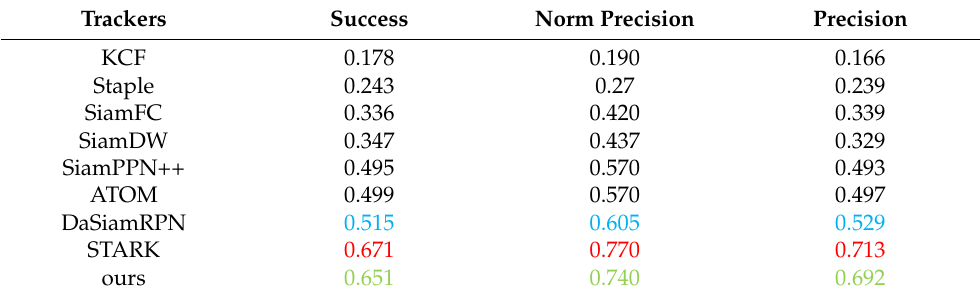
Table 6. Comparisons on VOT-LT2020 benchmark. The best three results are marked in red, green, and blue bold fonts, respectively. Table 5. Comparison of success rates for different attributes. The best three results are marked in red, green, and blue bold fonts,